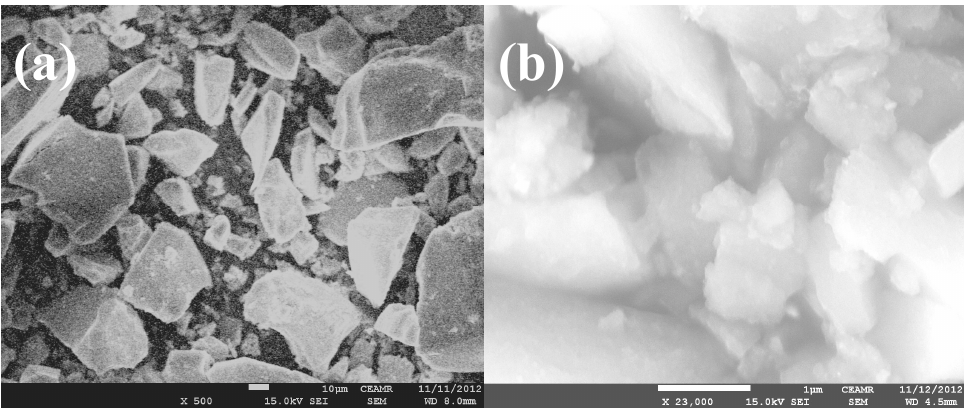
Figure 2. SEM images of ( a ) activated SG and ( b ) SG-APTMS-N,N-EPANTf 2 phases.